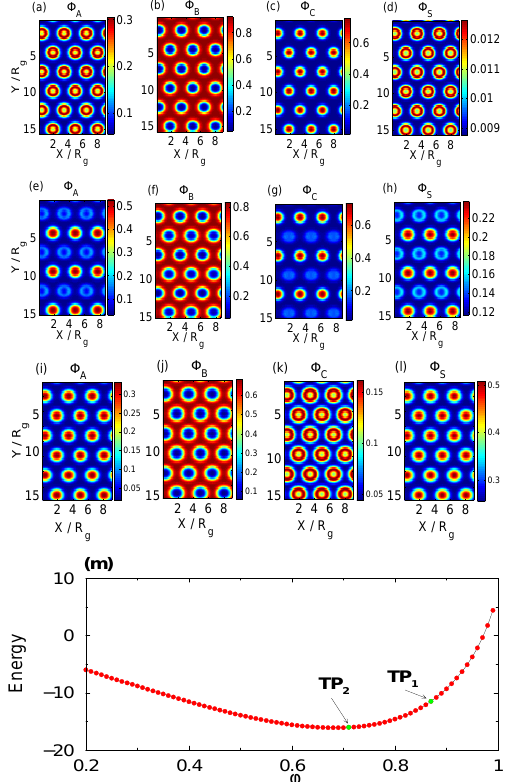
Figure 5. (a), (b) and (c) shows spatial monomer densities of A, B, and C components of the polymer and (d) the density of the solvent for polymer volume fraction φ = 0 . 99 , χ N = 34 , χ N = 24 , χ N = 50 and χ N = − 10 , χ N = χ N = 90 . (e), AB AC BC AS BS CS (f) and (g) shows spatial monomer densities of the A, B, and C components of the polymer and (h) the density of the solvent for polymer volume fraction φ = 0 . 886 . (Flory-Huggins parameters are as in (a-d)). (i), (j) and (k) shows spatial monomer densities of the A, B, and C components of the polymer and (l) the density of the solvent for polymer volume fraction φ = 0 . 65 . (m) Free energy of the mixture as a function of the polymer volume fraction φ . The transition points (TP ), (TP ) are marked on the 1 2